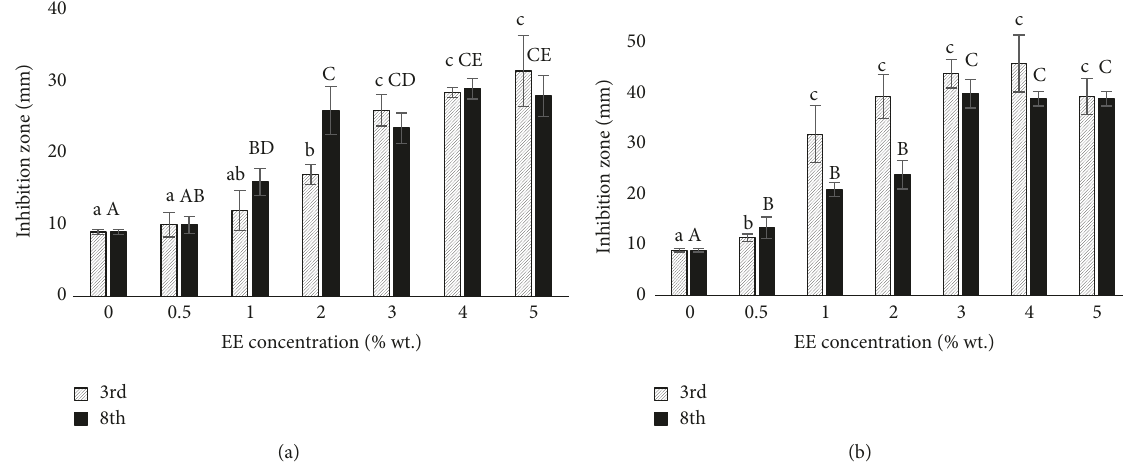
Figure 4: Antimicrobial activity of chitosan films with the oregano EO at days 3 and 8 against Gram-negative bacteria (a) Escherichia coli and (b) Salmonella typhimurium. The various lowercase and uppercase letters indicate significant differences ( 𝑃 < 0.05 ) between the films on the 3rd and 8th day subsequent to the day they were dried, respectively.